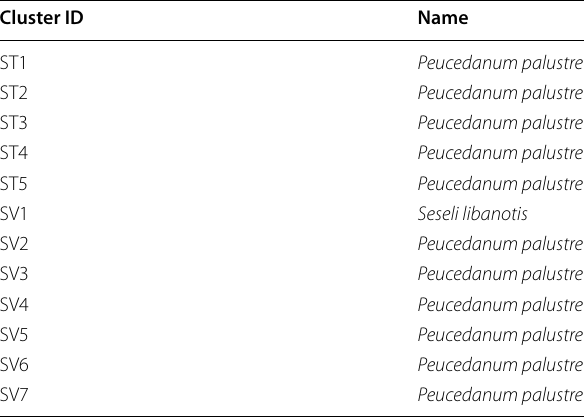
Table 7 Selinum cluster ID and names for rbcL Cluster